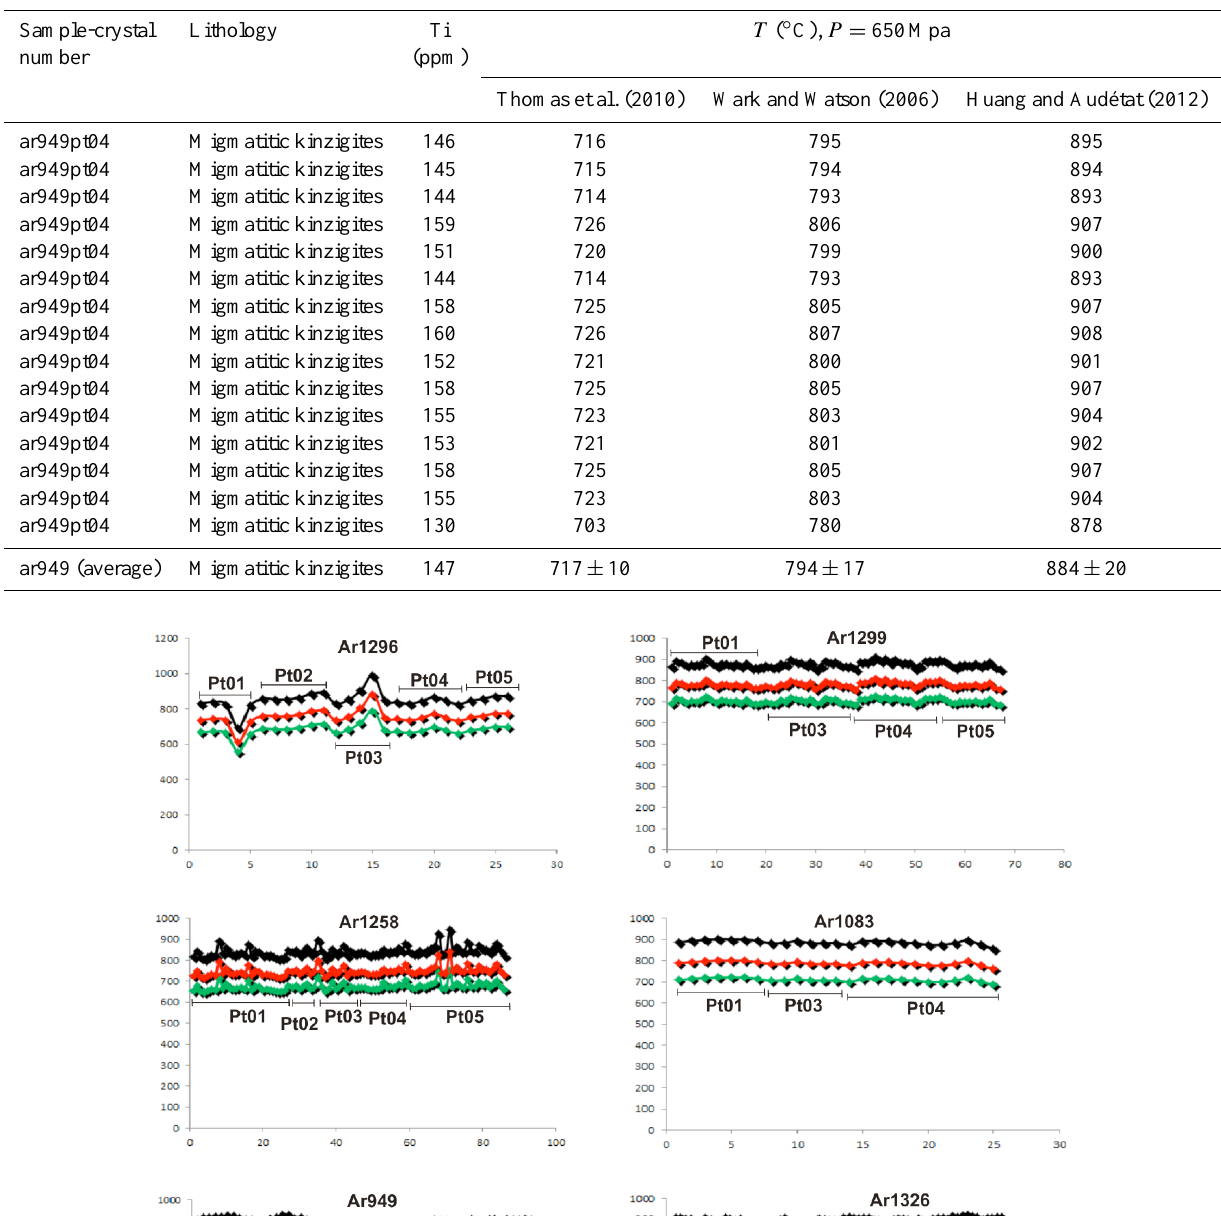
Solid Earth, 5, 1223–1242, 2014